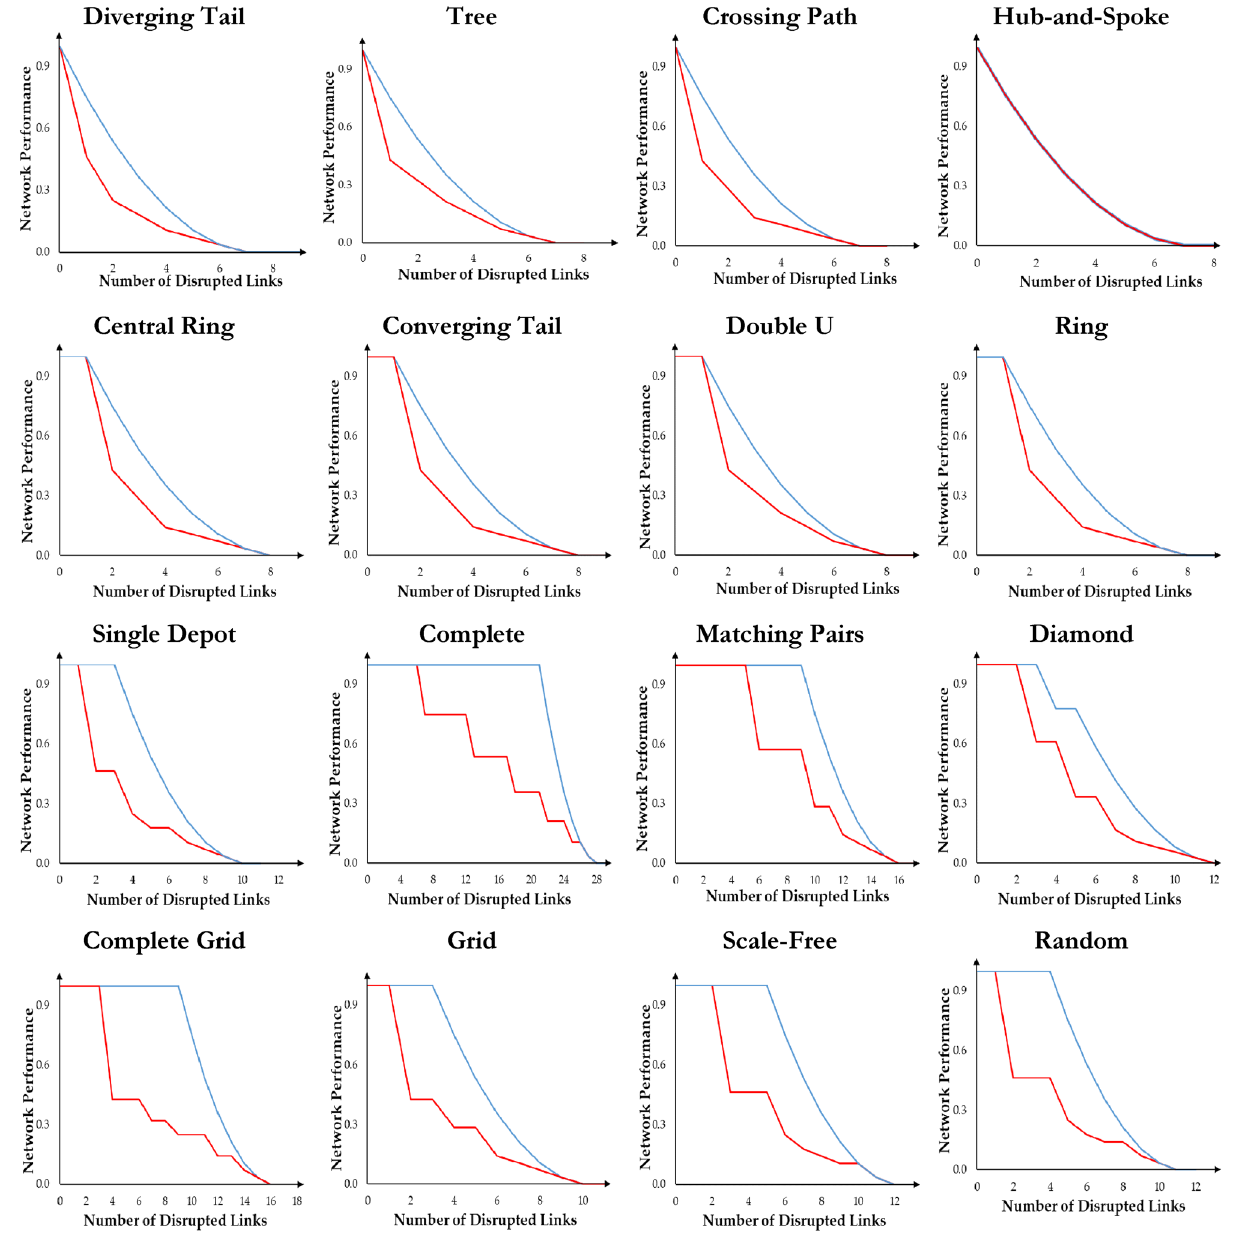
Figure 2. Disruption trajectory of 16 network topologies with 8 nodes. The x-axis represents the number of removed links. The y-axis represents the normalized network performance. Three observations are noted. First, topologies with no redundancy, such as Diverging Tail, Tree, Crossing Path, and Hub-and-Spoke, follow similar disruption trajectories with no delay in network performance devolution. For these topologies R e ( G ( N , L )) equals 1. Second, topologies with one undirected cycle, such as Central Ring, Converging Tail, Ring, and Double U, have one unit of delay in network performance degradations. After disconnecting the cycle, they follow disruption trajectories like the topologies with no redundancy. The redundancy measure for such N |− 1 networks equals | | N | . Third, in the presence of a malicious attack, the increase in the minimum number of undirected cycles in the network increases delays in the network performance degradations at the beginning of the disruption process. The minimum number of cycles in a network equals the minimum existing node degree in the network minus one. The number and length of delays in the middle of the disruptions process depends, respectively, on the existence of nodes with a minimum degree greater than two in the residual